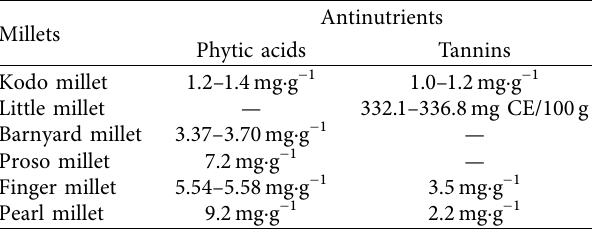
Table 4: Antinutrient compounds found in